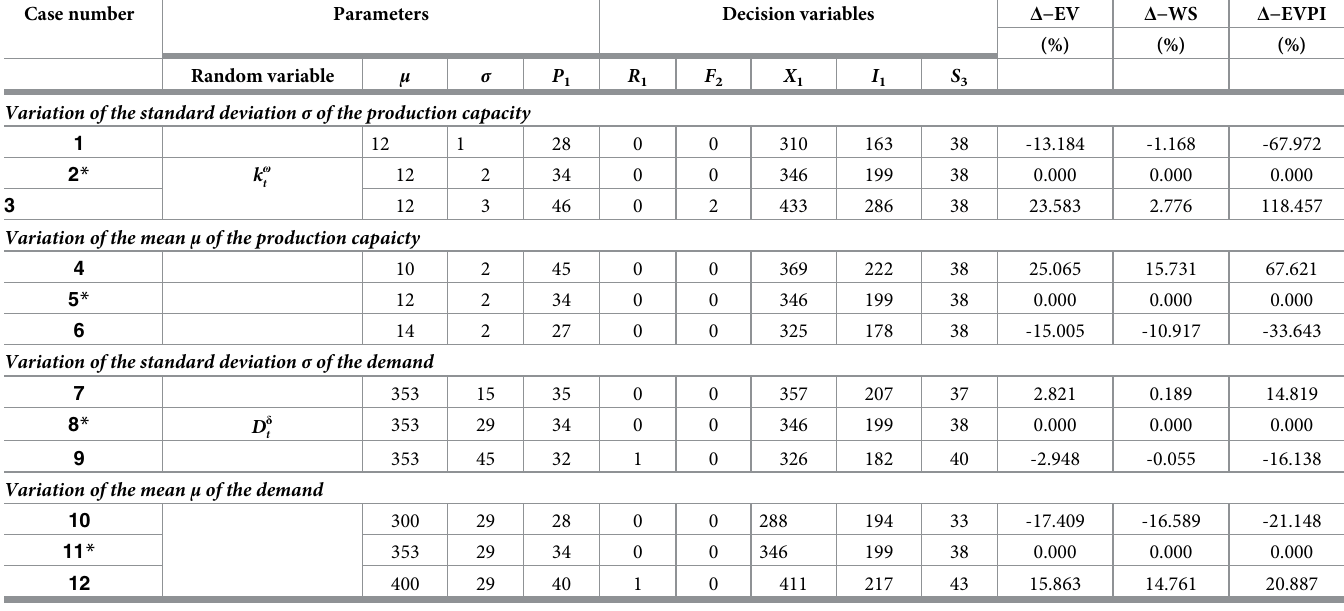
Table 14. Model-I sensitivity analysis varying parameters of the probability distribution. Own elaboration.